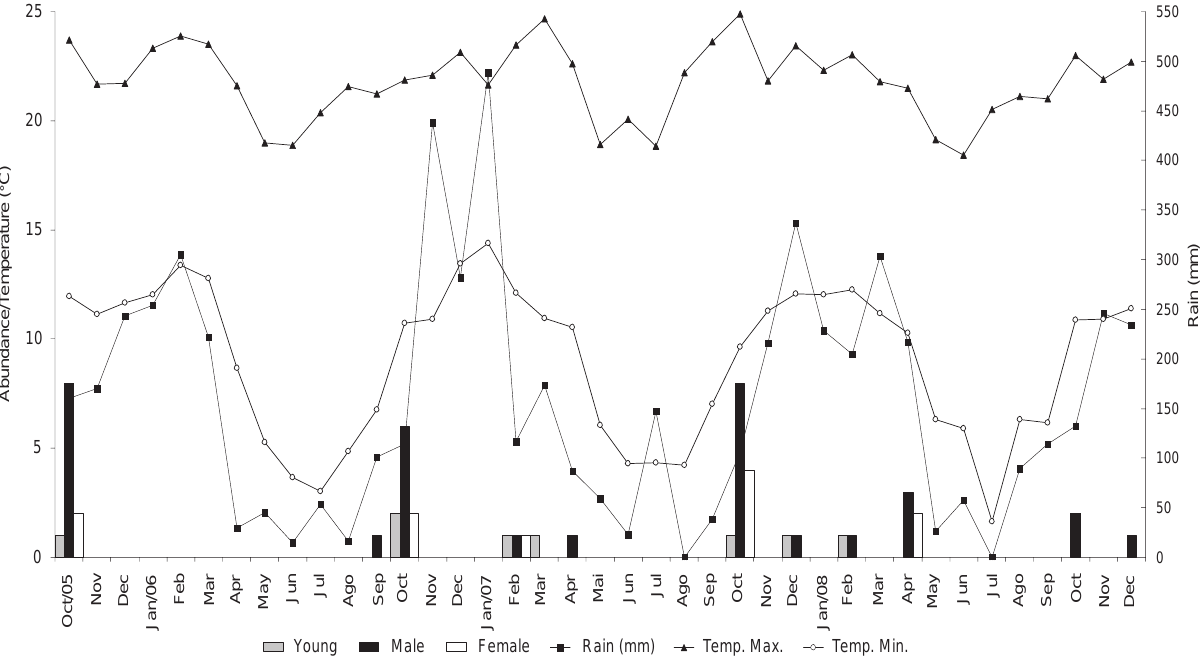
Figure 7. Abundance and temporal distribution of juveniles, males, and females of H. luederwaldti , and the maximum and minimum air temperature and total rainfall in the study months, recorded in the Parque Estadual de Campos do